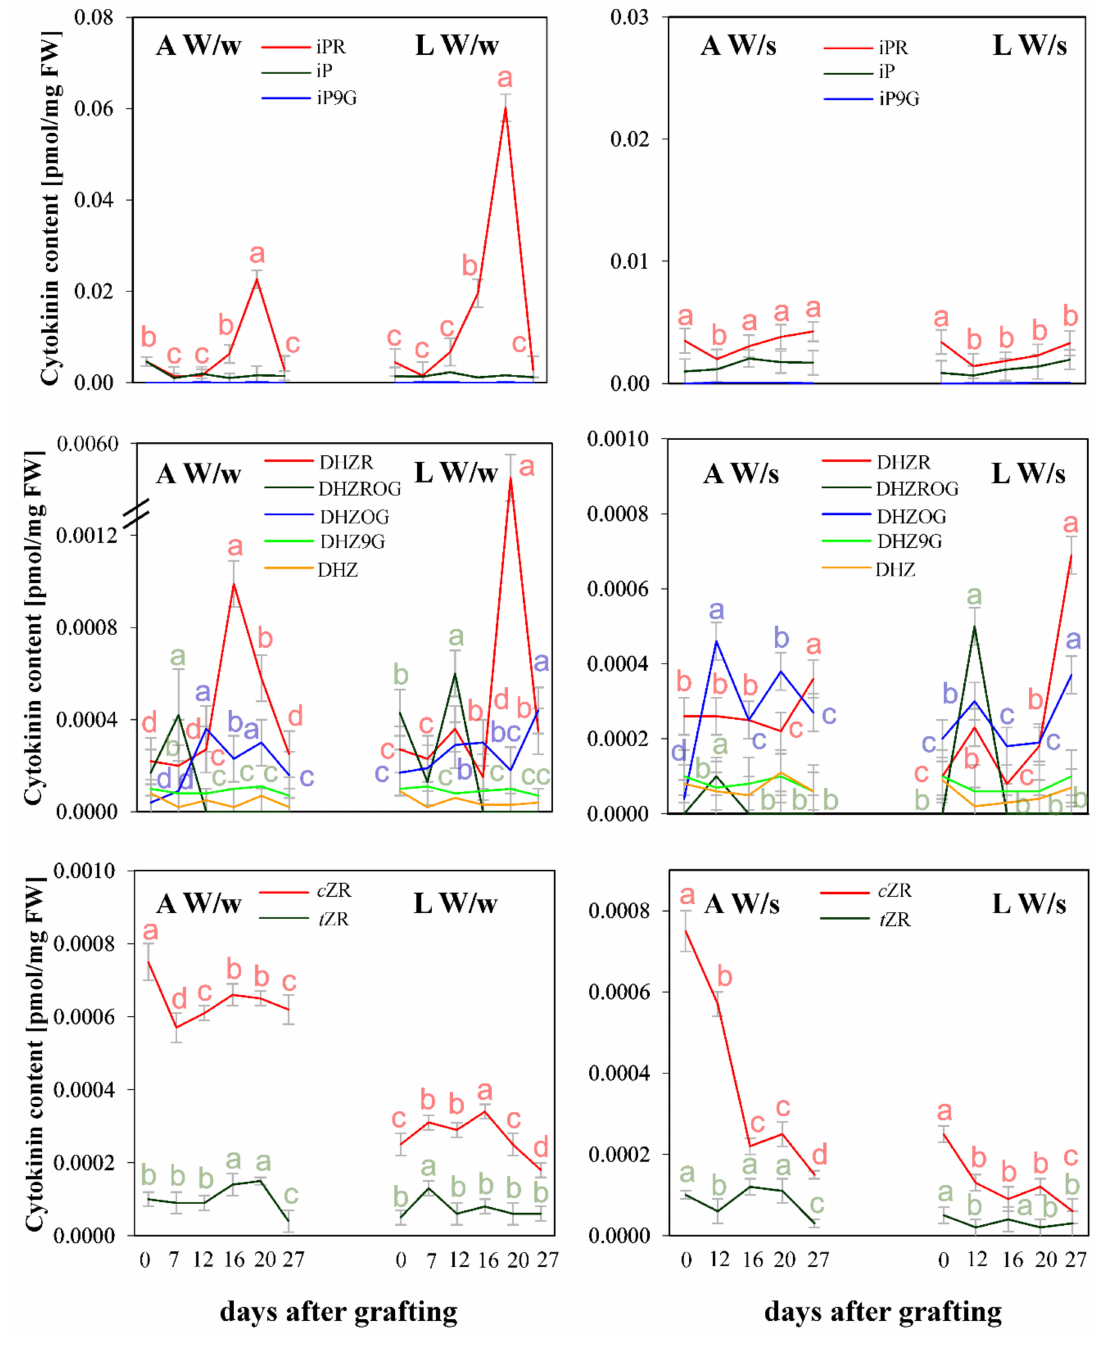
Figure 3. Content (pmol / mg FW) of N 6 -isopentenyladenine (iP), N 6 -isopentenyladenosine (iPR), N 6 -isopentenyladenine-9-glucoside (iP9G), dihydrozeatin (DHZ), dihydrozeatin riboside (DHZR), dihydrozeatin-9-glucoside (DHZ9G), dihydrozeatin O -glucoside (DHZOG), dihydrozeatin riboside O -glucoside (DHZROG) and cis ( c ) and trans ( t ) zeatin riboside ( c ZR, t ZR) in apices (A) and the youngest leaves (L) of the upper part of winter rapeseed plants after 0, 7, 12, 16, 20 and 27 days after grafting on winter, flowering plants (W / w) and after 0, 12, 16, 20 and 27 days after grafting on spring flowering plants (W / s). Significant di ff erences ( p ≤ 0.05) are marked as di ff erent letters according to Duncan’s